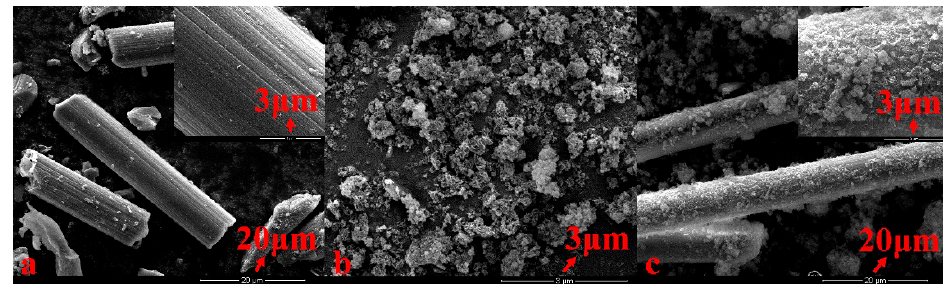
Figure 1. SEM of the catalysts: ( a ) activated carbon fibers (ACF); ( b ) Ni– γ –Al 2 O 3 ; ( c ) Ni– γ –Al 2 O 3 /ACF.